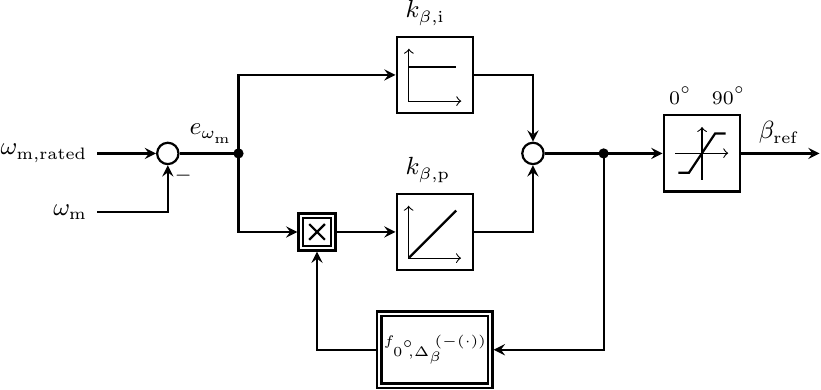
Figure 9. Nonlinear pitch reference PI